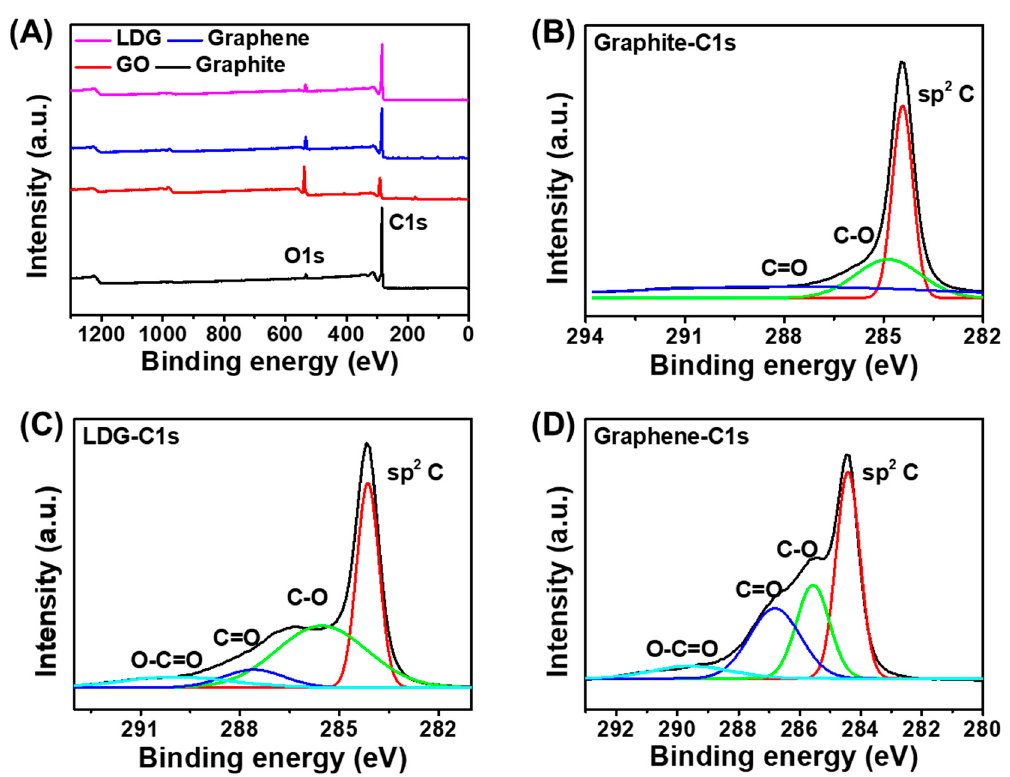
Figure 3. ( A ) XPS survey of LDG powder, commercially available graphene, graphene oxide and graphite with high-resolution C 1s spectra of ( B ) graphite, ( C ) LDG, and ( D ) commercially available graphene, respectively.